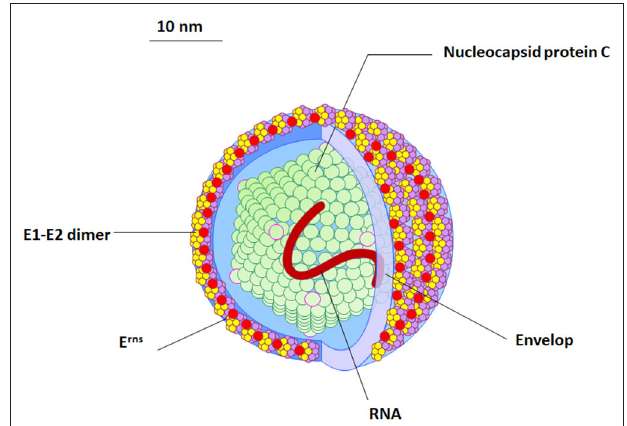
FIGURE 1 | The morphology and structure of BVDV virus. An illustration of the BVDV particle showing the morphology and structure of the virus. Four structural proteins (Protein C, Erns, E1, and E2) are enclosing RNA (red). The outer viral protein coat contains important E1–E2 heterodimers which is required for the virus